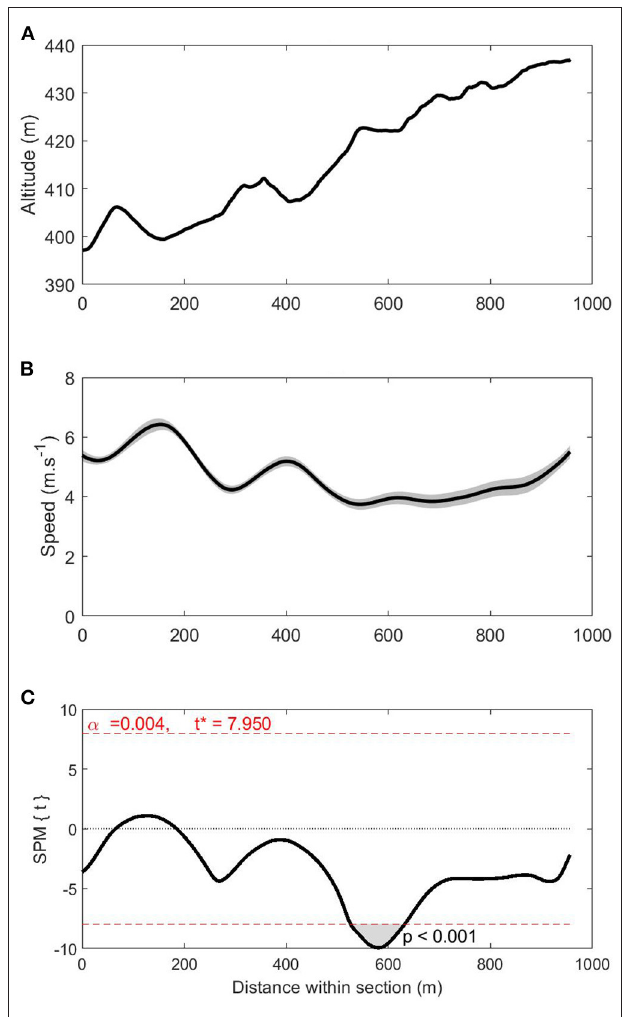
FIGURE 2 | Altitude (panel A ), speed (panel B ), and statistical parametric mapping (SPM{t}) curves (panel C ) for the women in S1 on lap 2 (i.e., the course section where race time was significantly related to instantaneous skiing speed). The shaded area on the speed curve represents the 95% confidence interval. The shaded area on the SPM{t} curve shows the course location where a significant relationship exists between race time and instantaneous speed (at 523–632m). * p < 0.05.